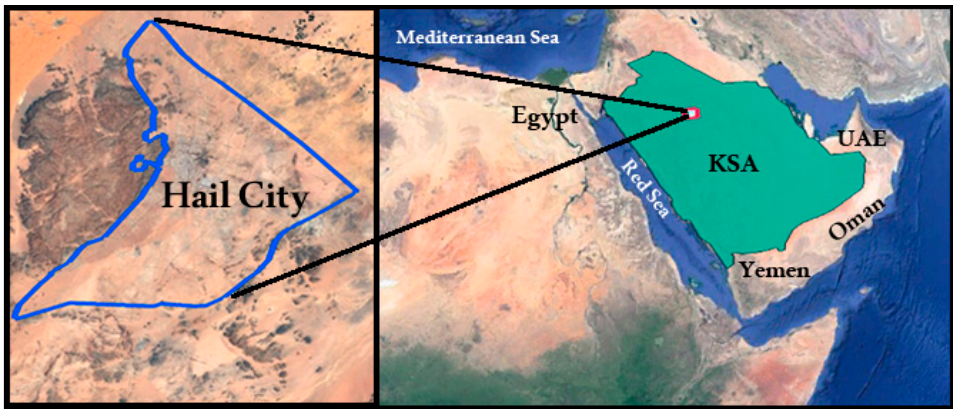
Figure 1. The location of the study area (Hail City).